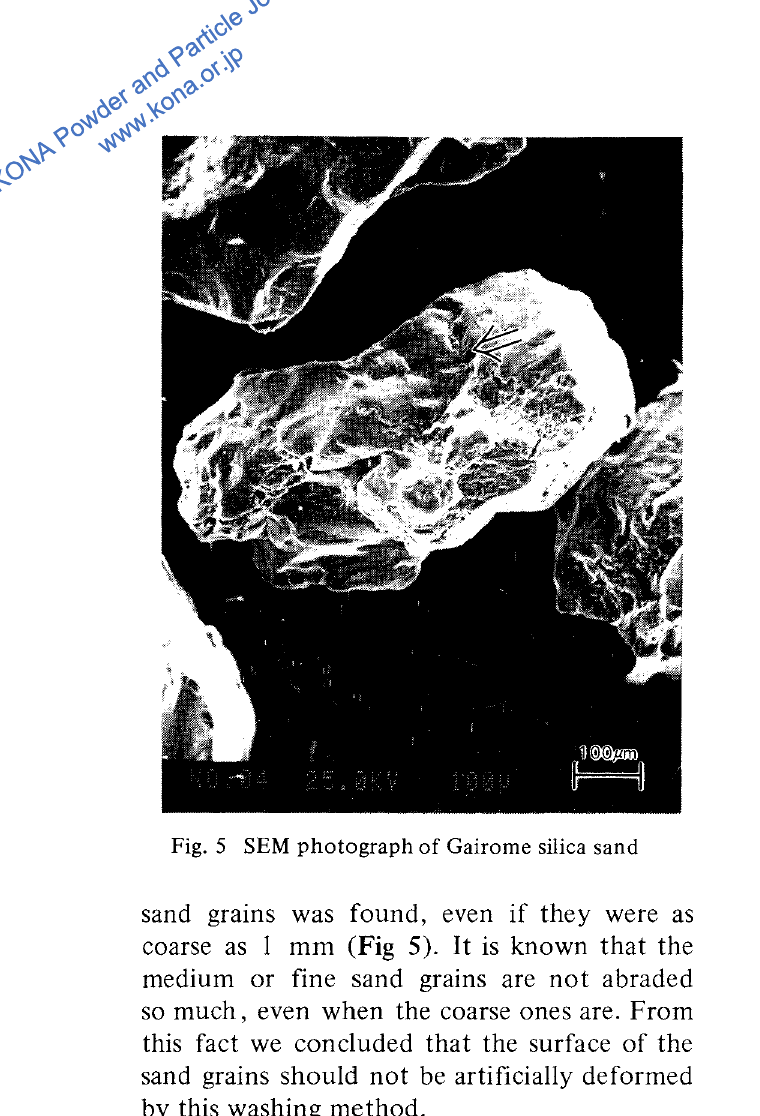
Fig. 5 SEM photograph of Gairome silica